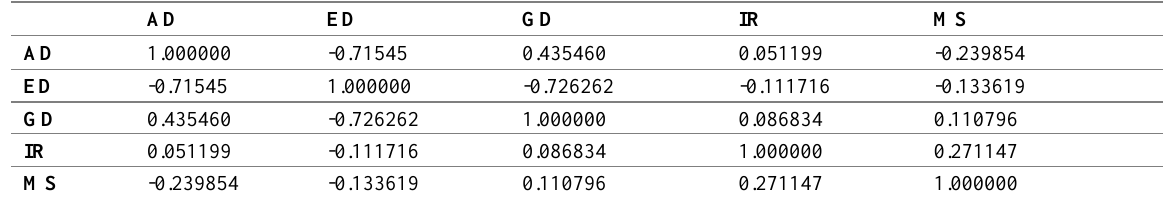
Table 6: Multicollinearity Test Results